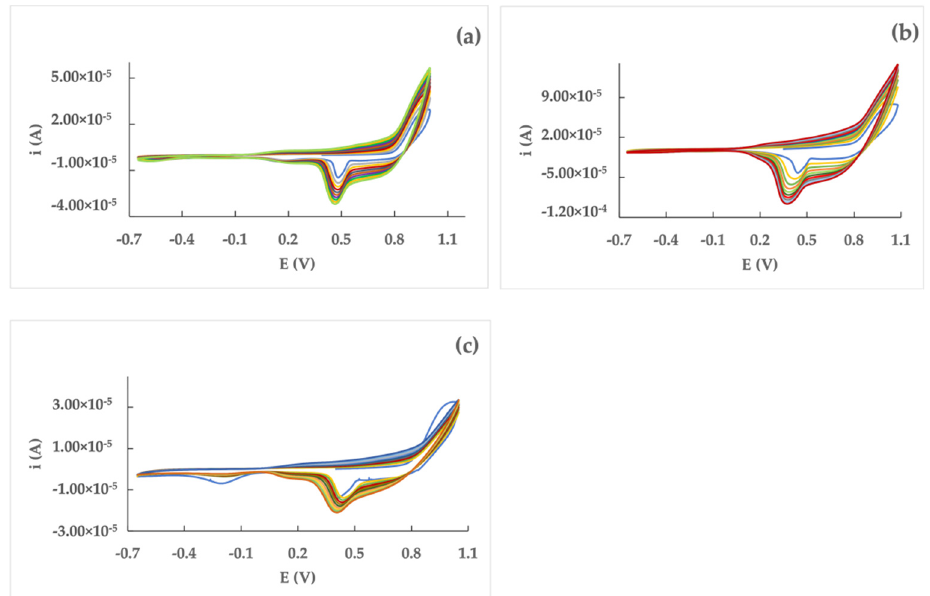
Figure 2. Cyclic voltammetry polymerization (10 cycles) of 1 mM dTT − bT in 0.1 M TEAPF 6 /CH 2 Cl 2 solution. WE: ( a ) Pt; ( b ) GC; ( c ) Au. RE: Ag/AgCl. CE: graphite bar. Potential scan rate: 100 mV s − 1 .